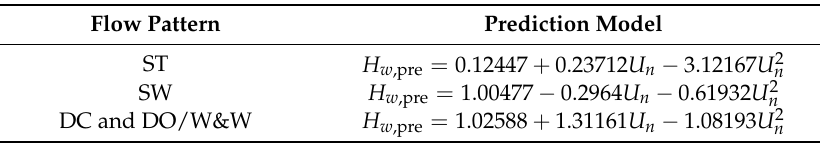
Table 2. Water holdup prediction model based on phase shift response.